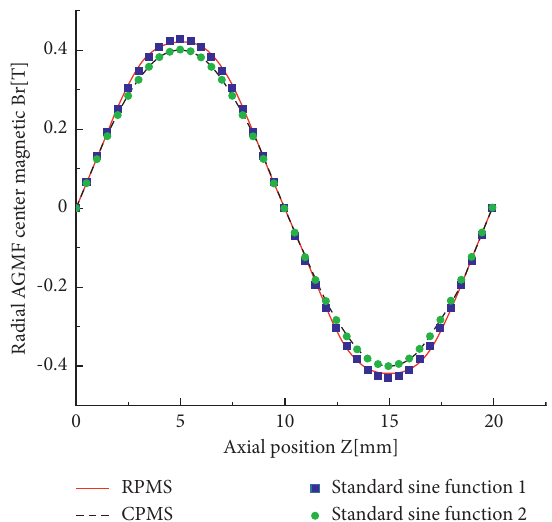
Figure 16: Radial AGMF magnetic induction intensity of CPMS and RPMS.